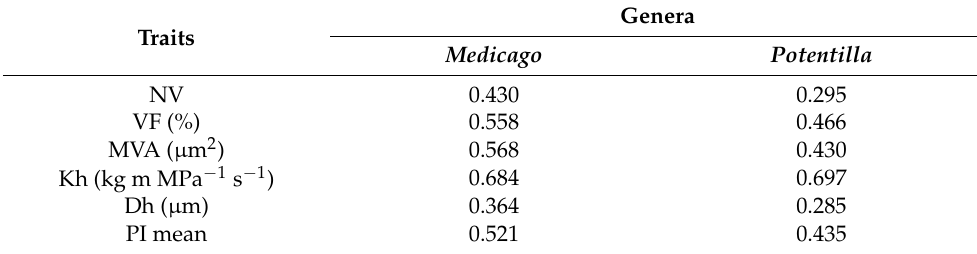
Table 2. Plasticity index (PI) of anatomical traits of non-native and native forbs. Traits